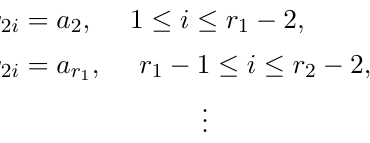
= a and q = a . In other words, we take the 2 2 2 n − 7 n − 1